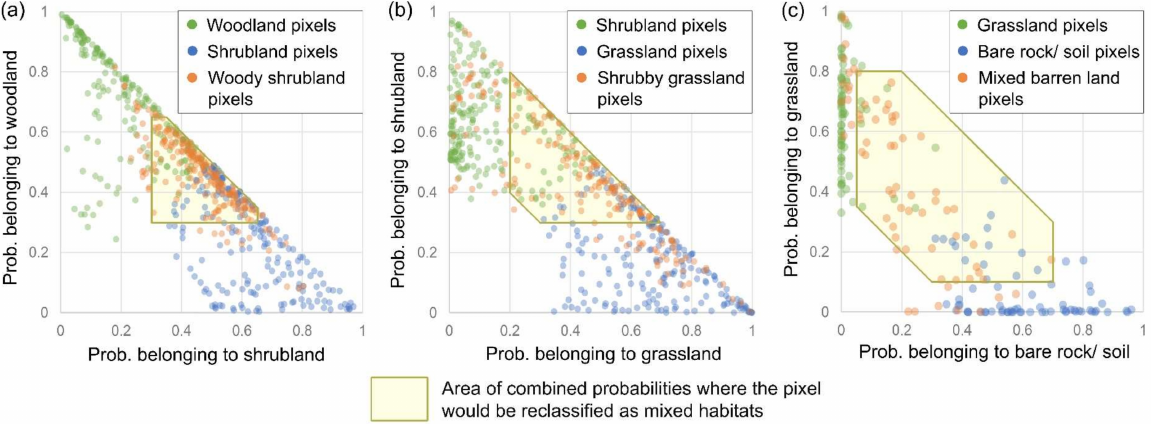
Figure 5. Illustration of development of the mixed habitat classes based on probabilities belonging